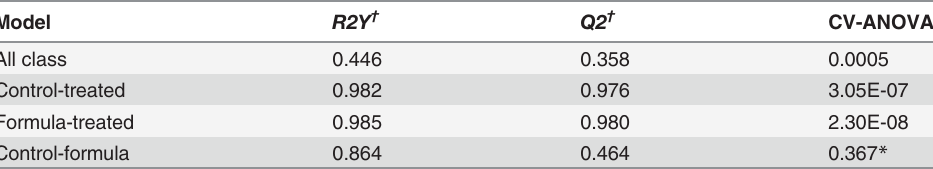
Table 1. OPLS-DA model